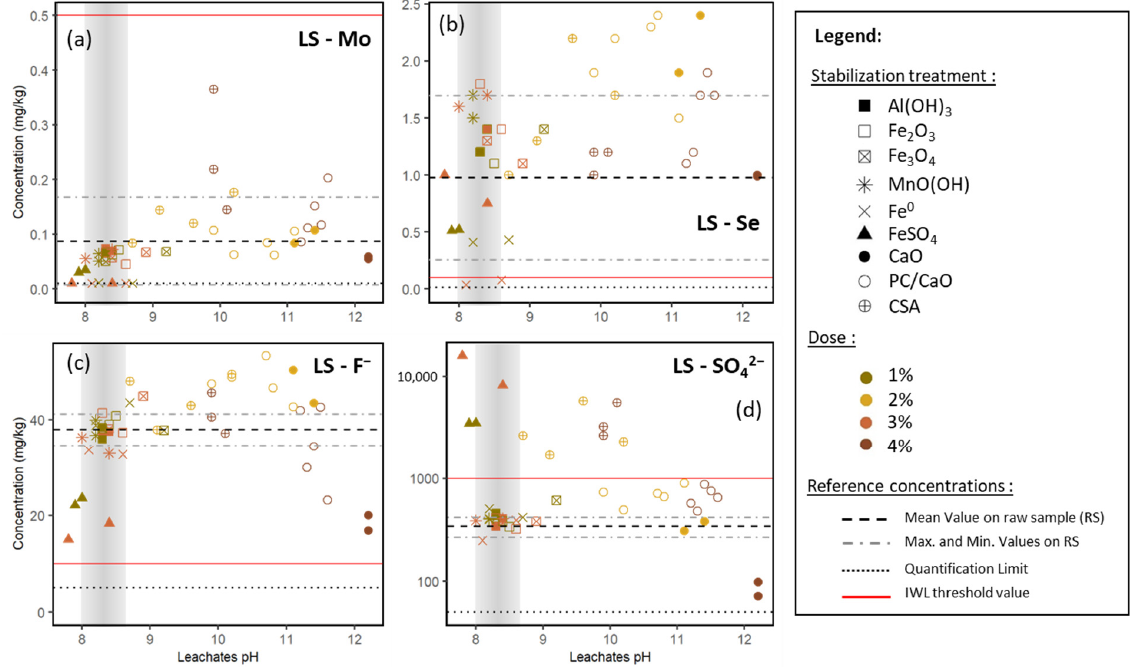
Figure 2. Mo ( a ), Se ( b ), fluorides ( c ) and sulfates ( d ) concentrations in the leachates of standardized leaching tests as a function of pH and of the stabilizing treatment in LS. Vertical gray areas represent the samples commonly observed natural pH. Attention has to be paid on the logarithm scale for LS-SO 42 − ( d ).